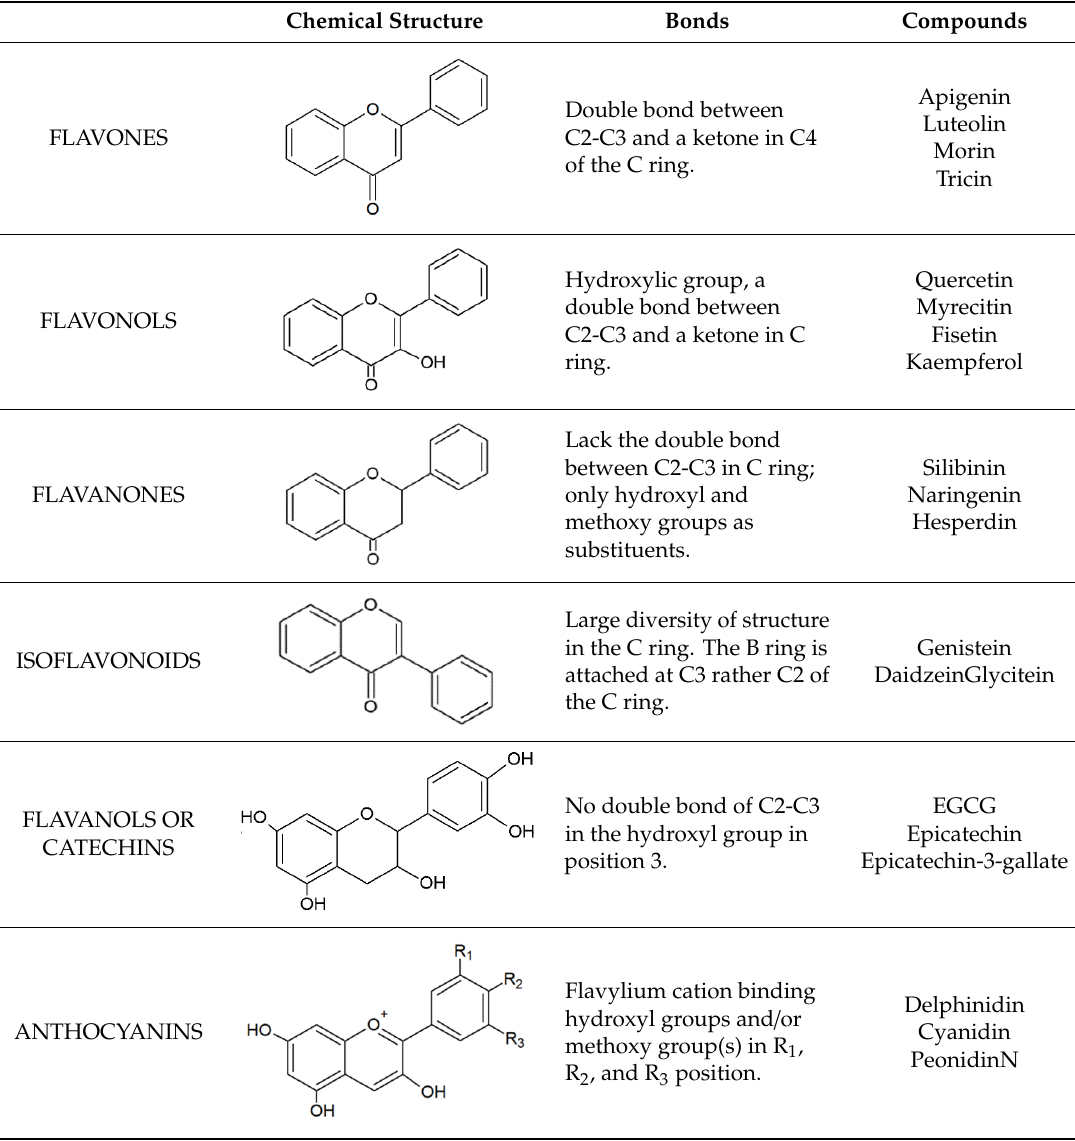
Table 1. Structure of the main flavonoid compounds. Based on their structural di ff erences, flavonoids can be divided into flavones, flavonols, flavanones, isoflavonoids, flavanols, and anthocyanins. Flavonoids whose epigenetic action is detailed in the text are in